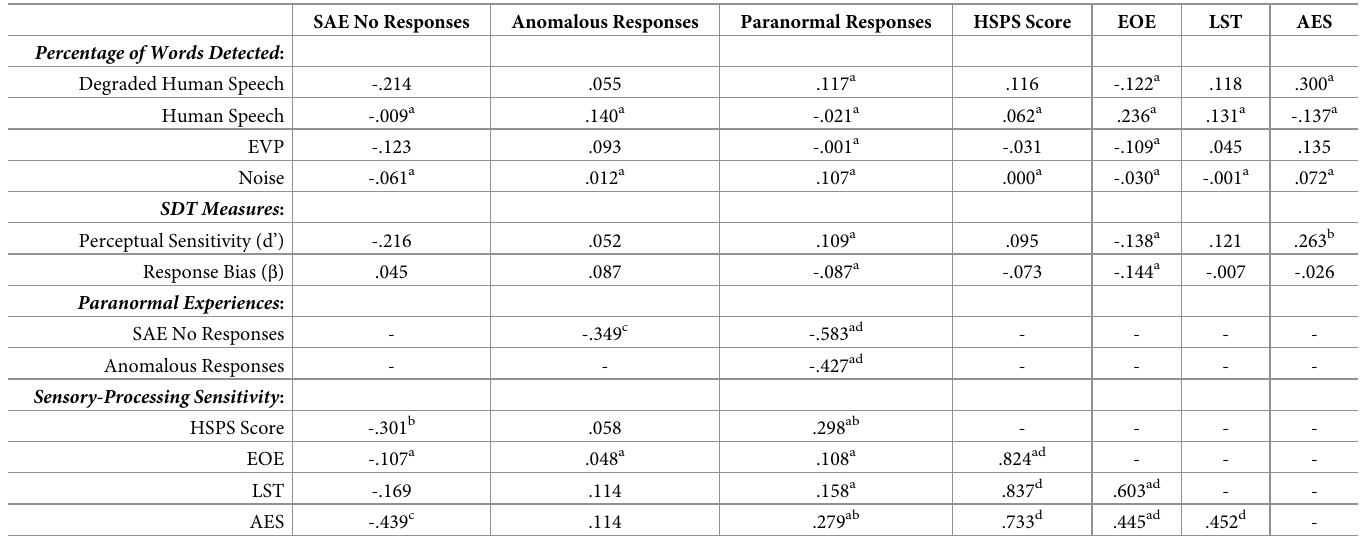
Table 1. Correlations between the perception, paranormal experiences, and sensory-processing